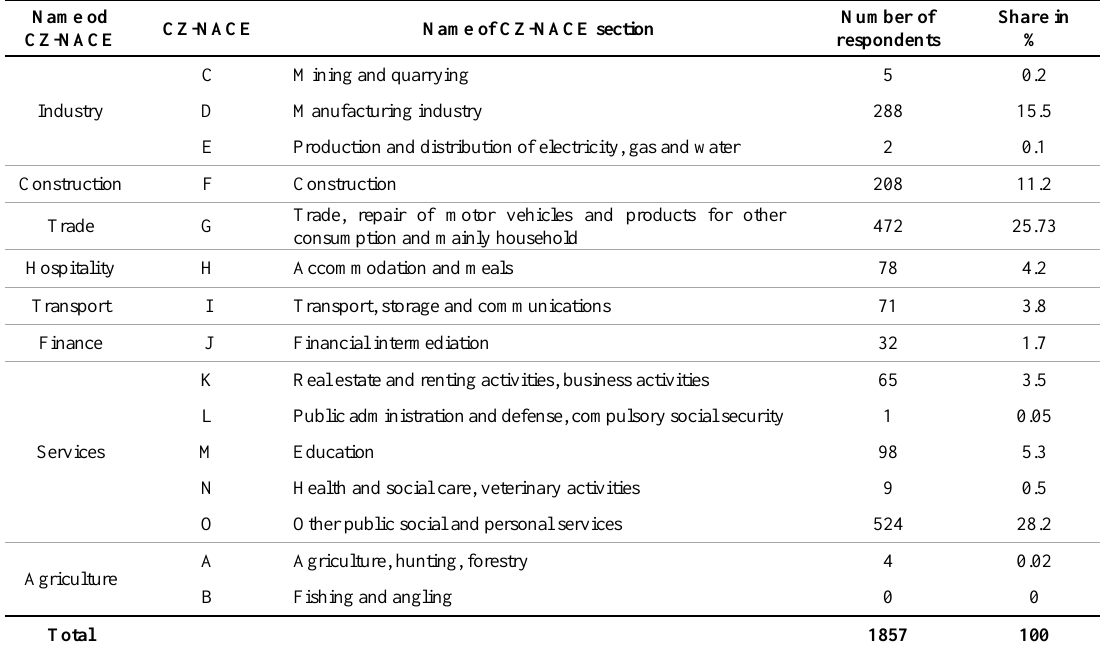
Table 2. Respondents according to the individual sections of the